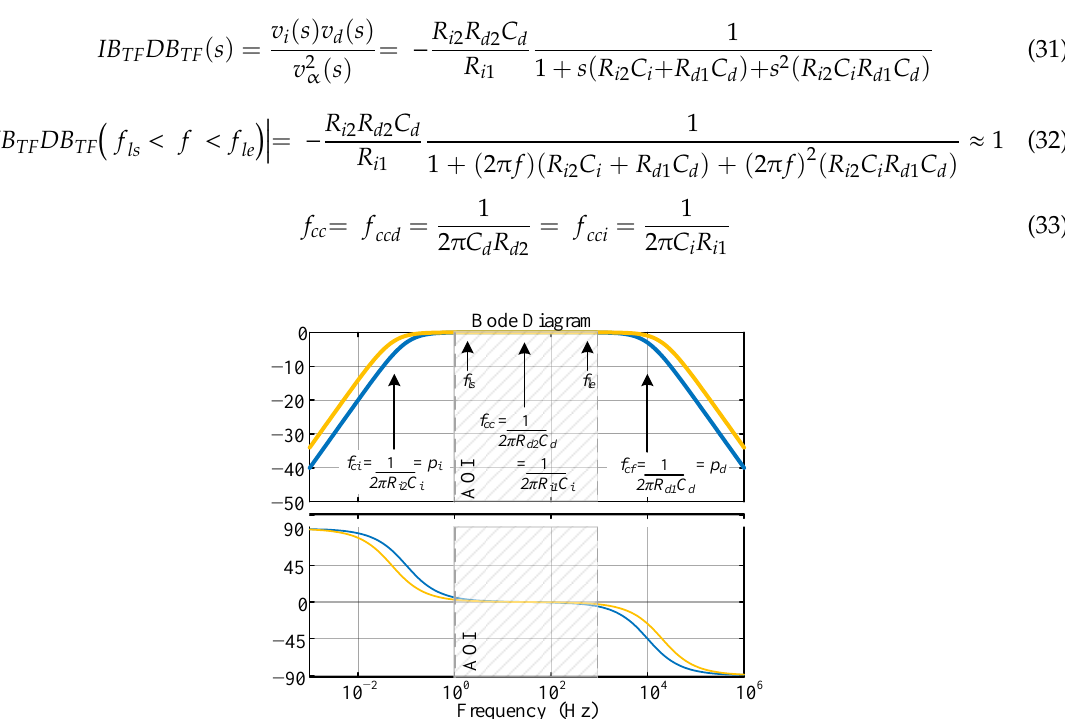
Figure 12. Result of the multiplication of v d and v i for design example—amplitude (top) phase (below)—first case (ς = 10) in blue, second in orange (ς = 20).